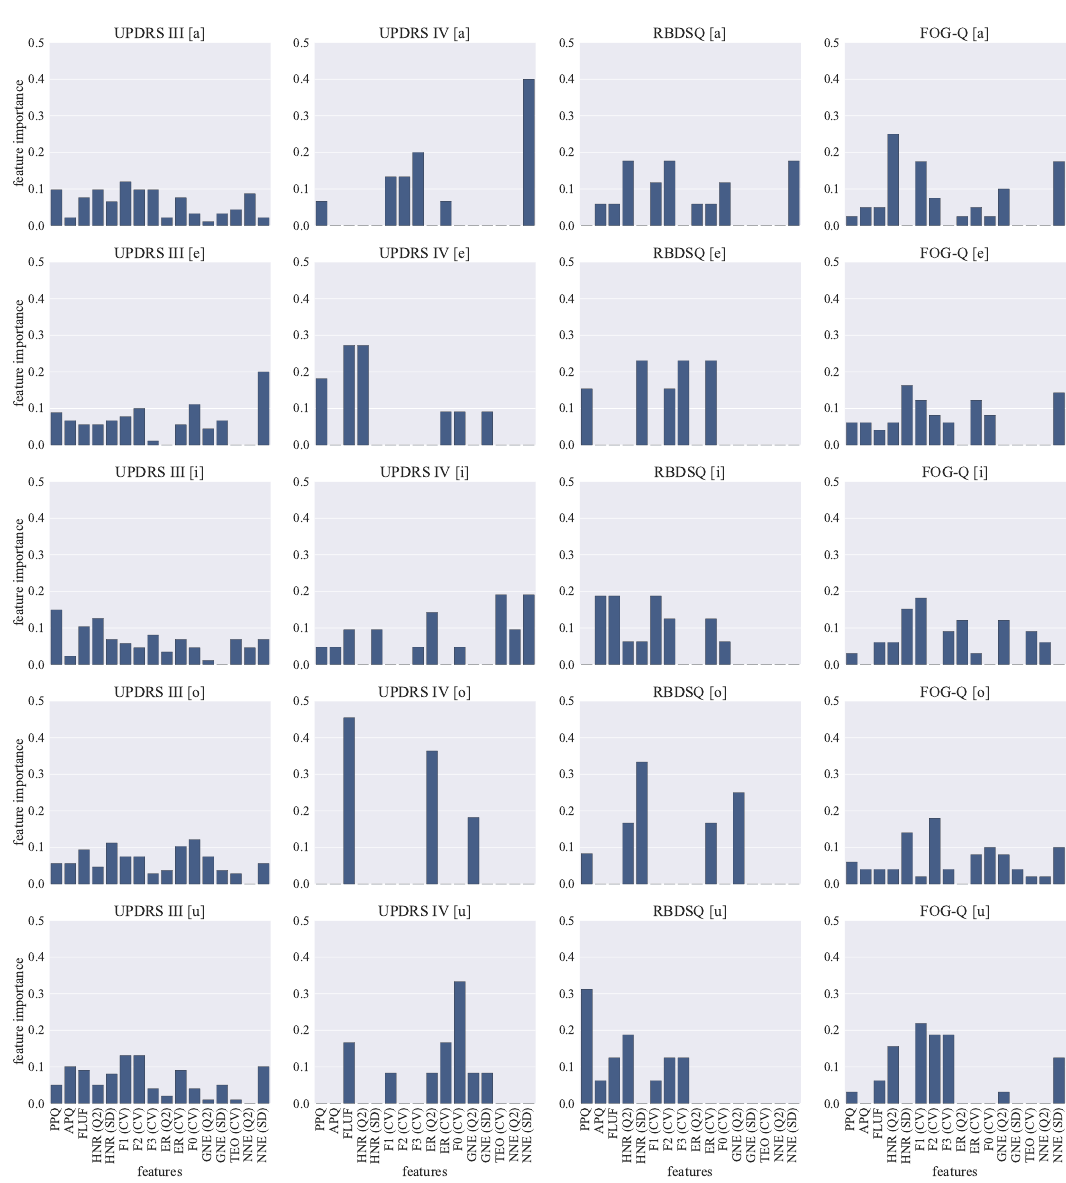
Figure 2. Feature importance graphs for trained XGBoost models. Each column shows graphs for the models trained to estimate the change ( ∆ ) in values of a particular clinical rating scale (UPDRSIII, UPDRSIV, RBDSQ, FOG-G). Each row shows graphs for the models trained using the features extracted from the recordings of a particular vowel phonation (/a/, /e/, /i/, /o/, /u/). The scale of the graphs is unified so that it is easier to compare the values among the